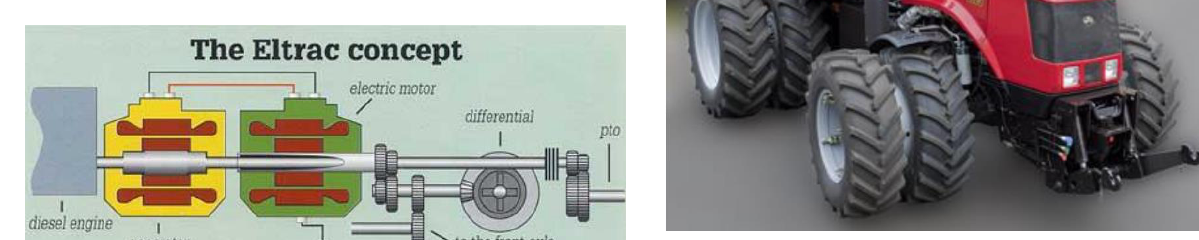
Fig. 7. Belarus 3023 with electro-mechanical powertrain